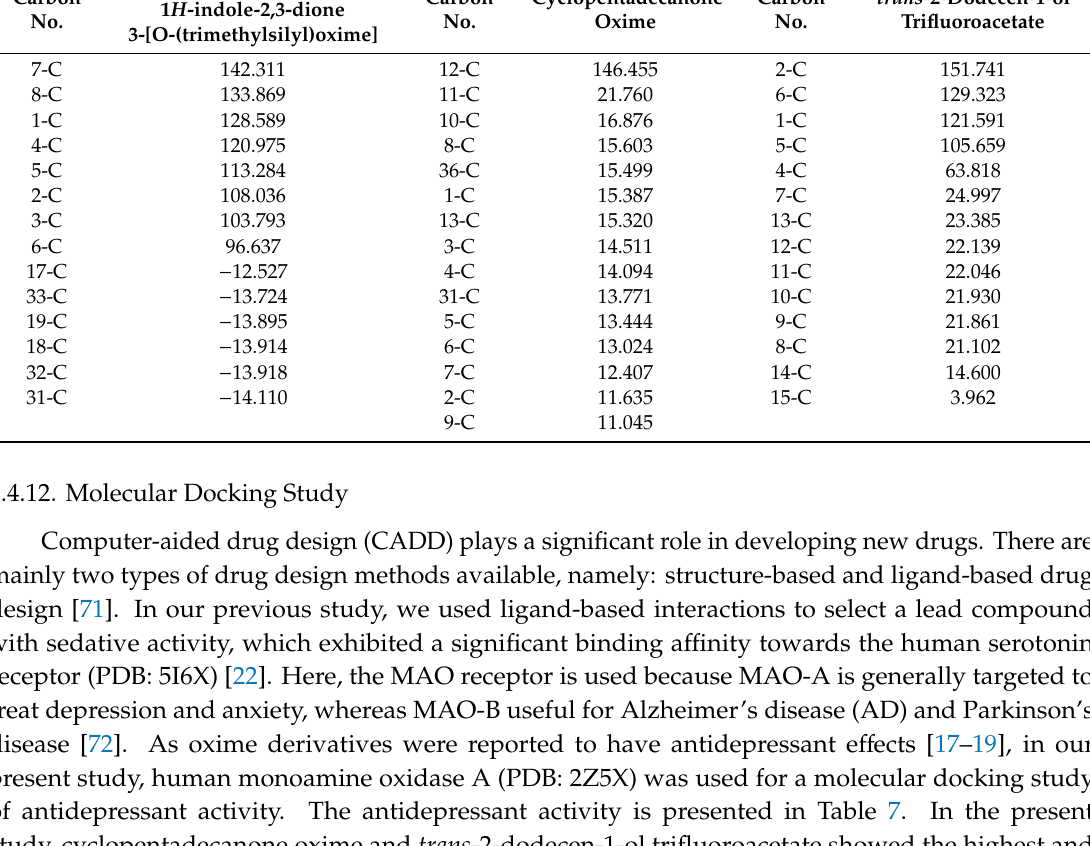
Table 6. Calculated 13 C-NMR isotropic chemical shift (TMS and chloroform solution) by the DFT / B3LYP / 6-31G + (d,p) method (atom positions numbered in the table). Compound (Chemical Shift-ppm) Carbon